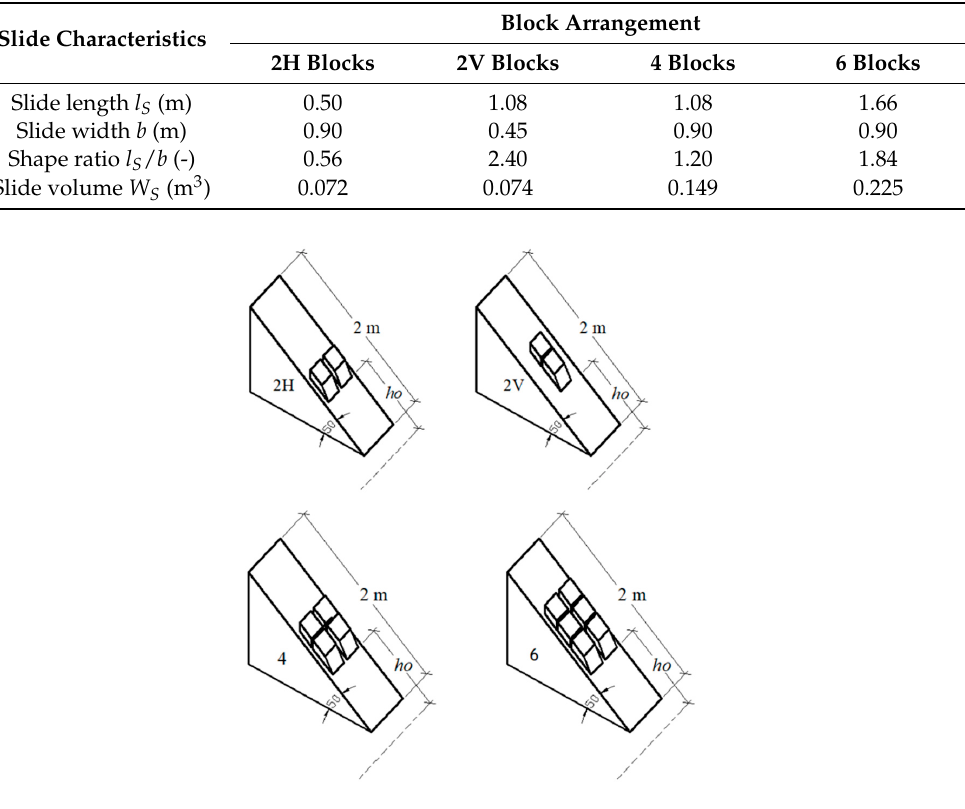
Figure 7. Arrangement of block configurations used in the tests with slide release height h o parallel to the ramp slope and measured from the still-water level.